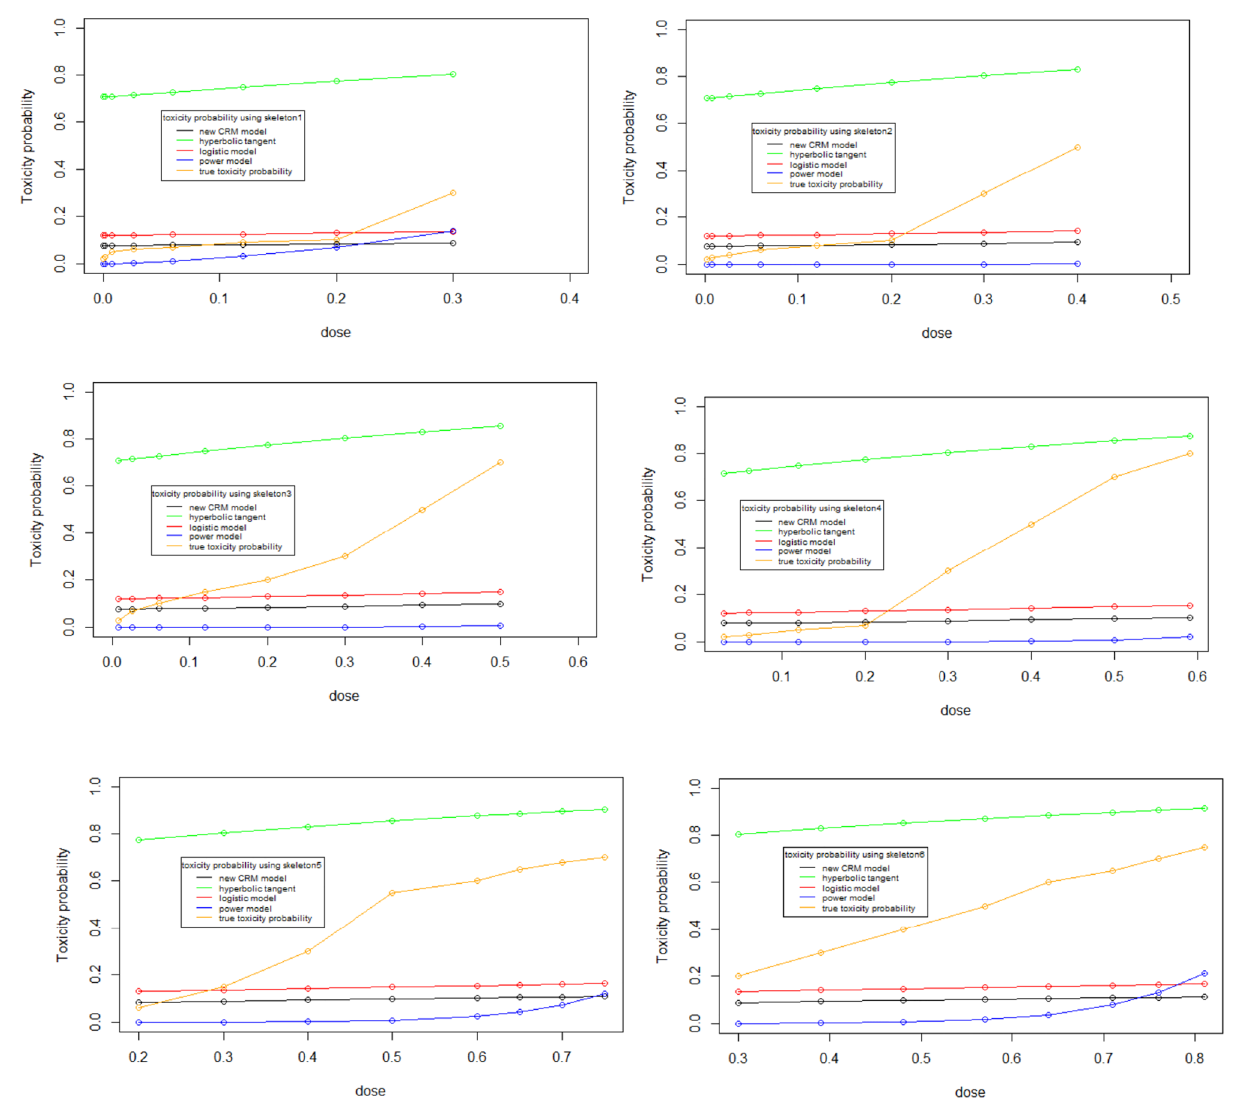
Figure 1. Toxicity probability using 6 different